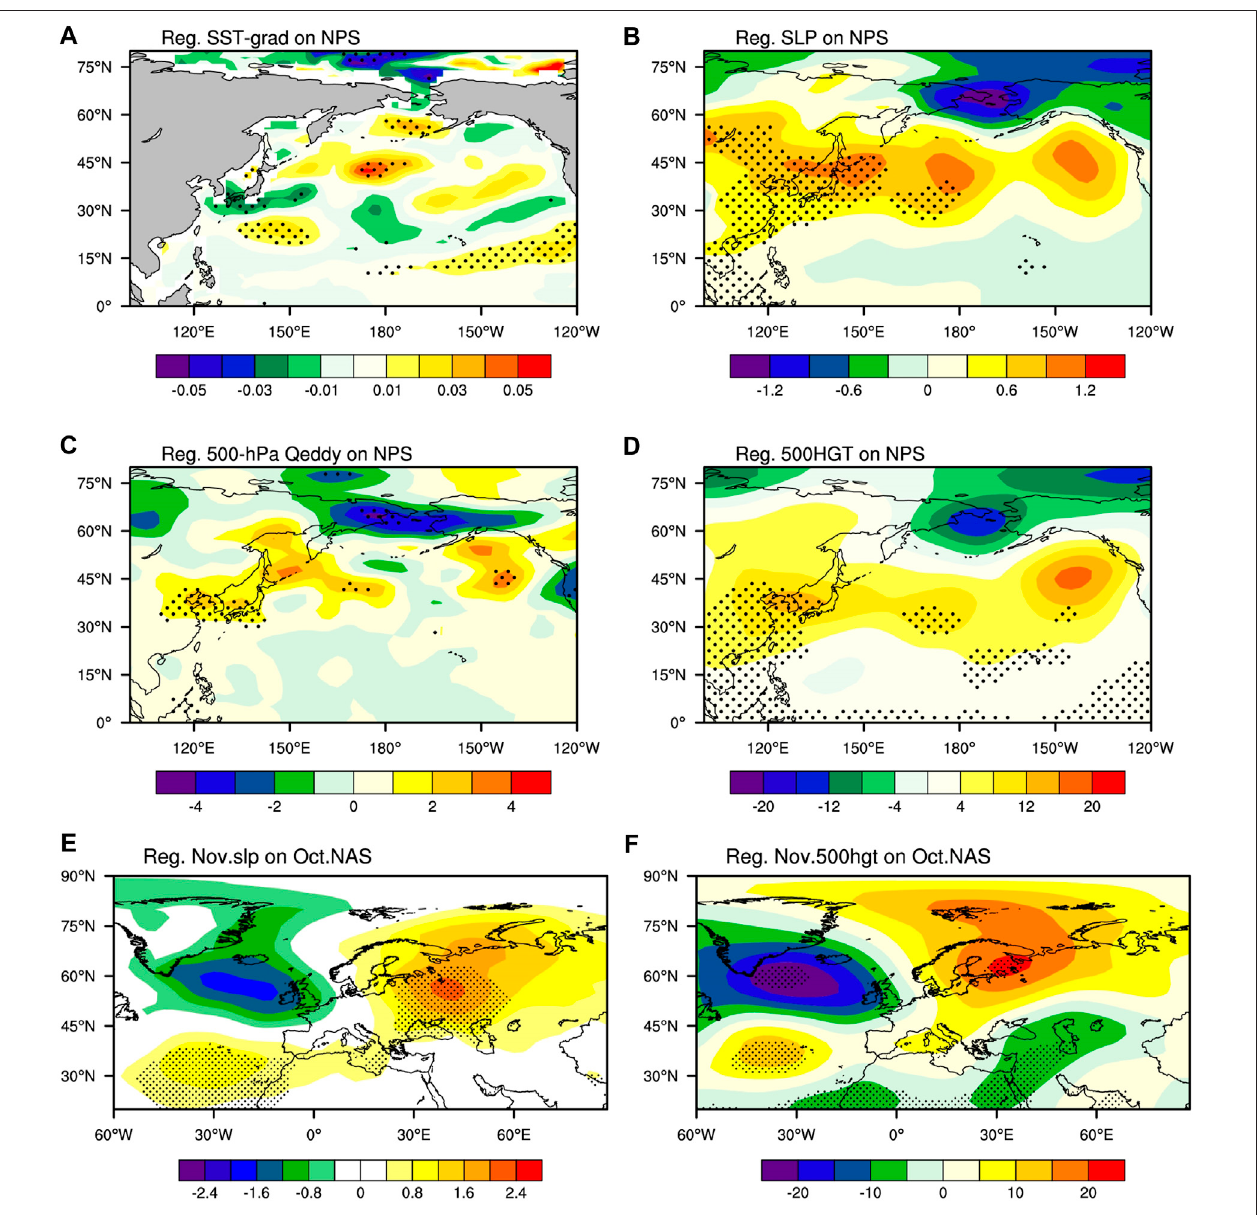
FIGURE8| RegressionoftheNovember (A) SSTgradient(unit: ° C km − 1 ), (B) SLP(unit:hPa), (C) 500-hPatransienteddyvorticityforcing(unit:day − 1 ),and (D) 500- hPaHGT(unit:gpm)ontheOctoberNorthPaci fi cSSTAindexduring1979 – 2019.RegressionoftheNovember (E) SLP, (F) 500-hPaHGTontheOctoberNorthAtlantic SSTA index. Regions above the 90% signi fi cance level are dotted. Regions above the 90% signi fi cance level are dotted.